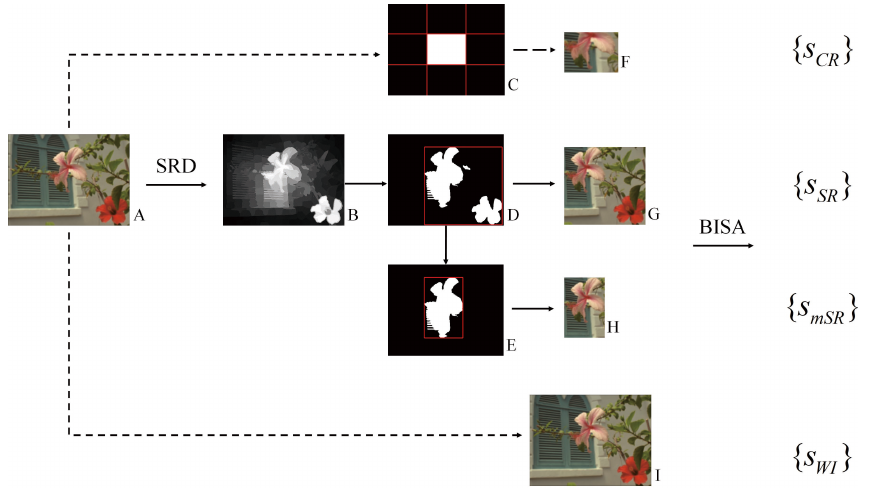
Figure 2. The proposed hybrid framework and experiment design. Under different image input scenarios, the performance of salient-region-guided image sharpness estimation is